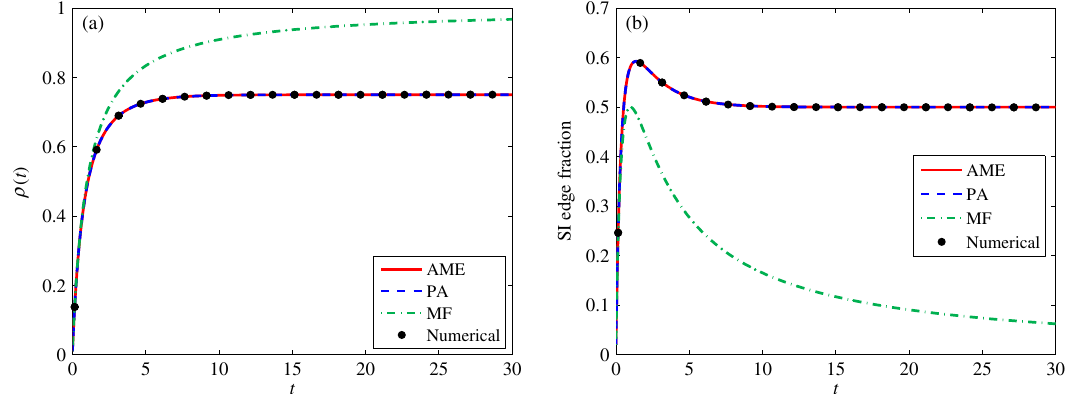
¼ (cid:4) ), with parameters c ¼ 1 and k k; 4